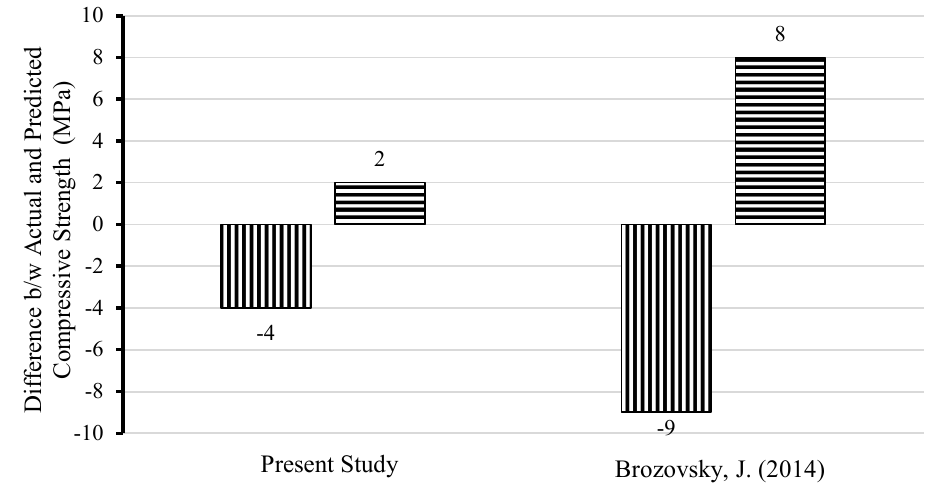
Figure 8. Maximum difference between actual and predicted strength [11].